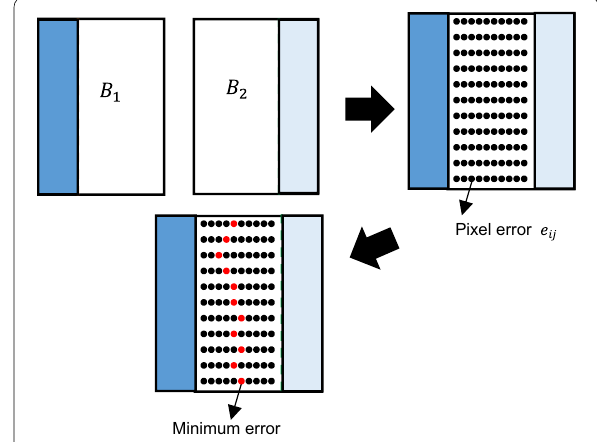
Figure 6 Minimum error boundary cut